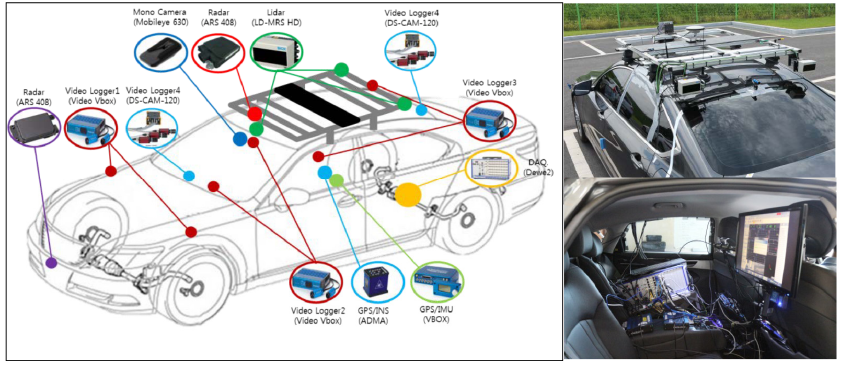
Figure 2. Implementation of data acquisition environment.